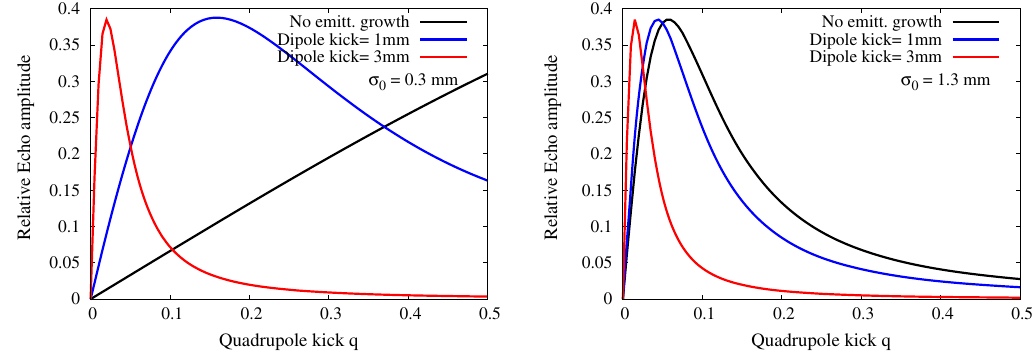
FIG. 1. Echo amplitude relative to the dipole kick as a function of quadrupole kick predicted by Eq. (2.36). The two plots are for different initial emittances. In each plot, the black curve shows the prediction without including the emittance growth from a dipole kick, the blue and red curves include emittance growth from dipole kicks of 1 mm and 3 mm,